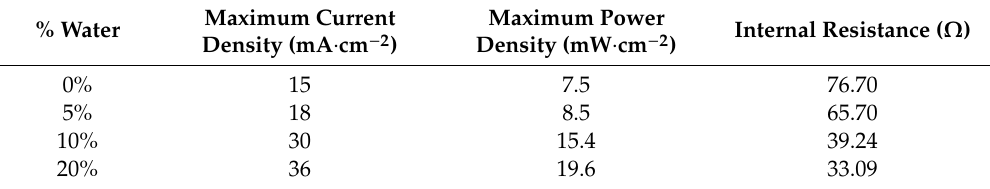
Table 3. The maximum current density, power density, and internal resistance of the dual-electrolyte AAB using an anolyte of methanol solutions containing 3 M KOH with di ff erent ratios of water (0%, 5%, 10%, and 20% (v /